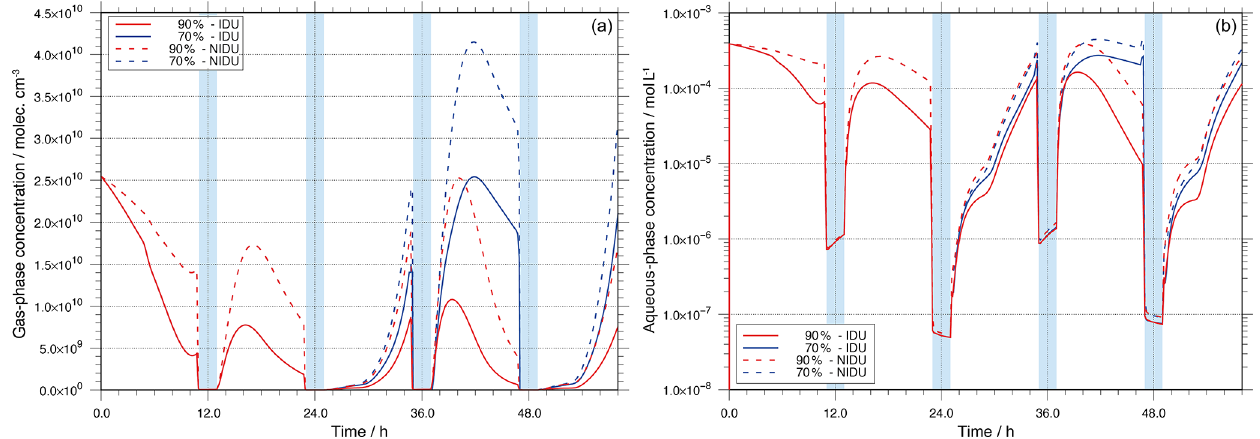
Figure 6. Modelled gas- and aqueous-phase concentrations of H 2 O 2 throughout the simulation time for the different urban simulation cases